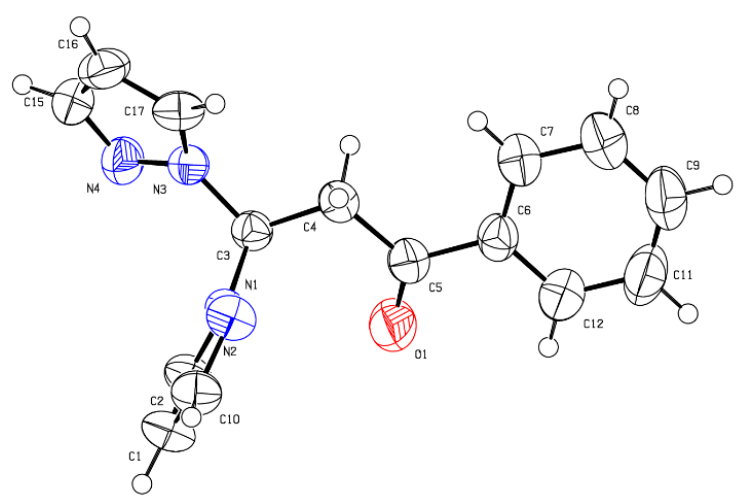
Figure 1. X-ray structure of 1-phenyl-3,3-di(1 H -pyrazol-1-yl)propan-1-one ( 3 ). Thermal ellipsoids set at 50% probability.